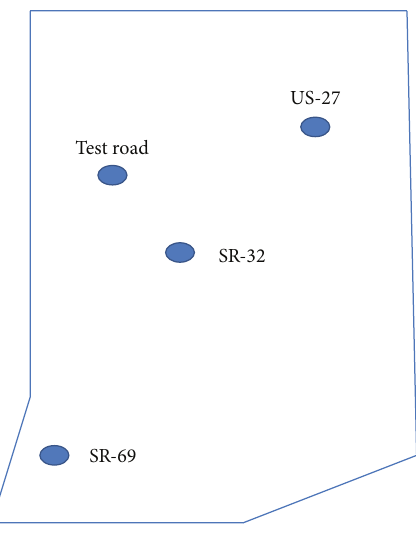
Figure 6: Existing